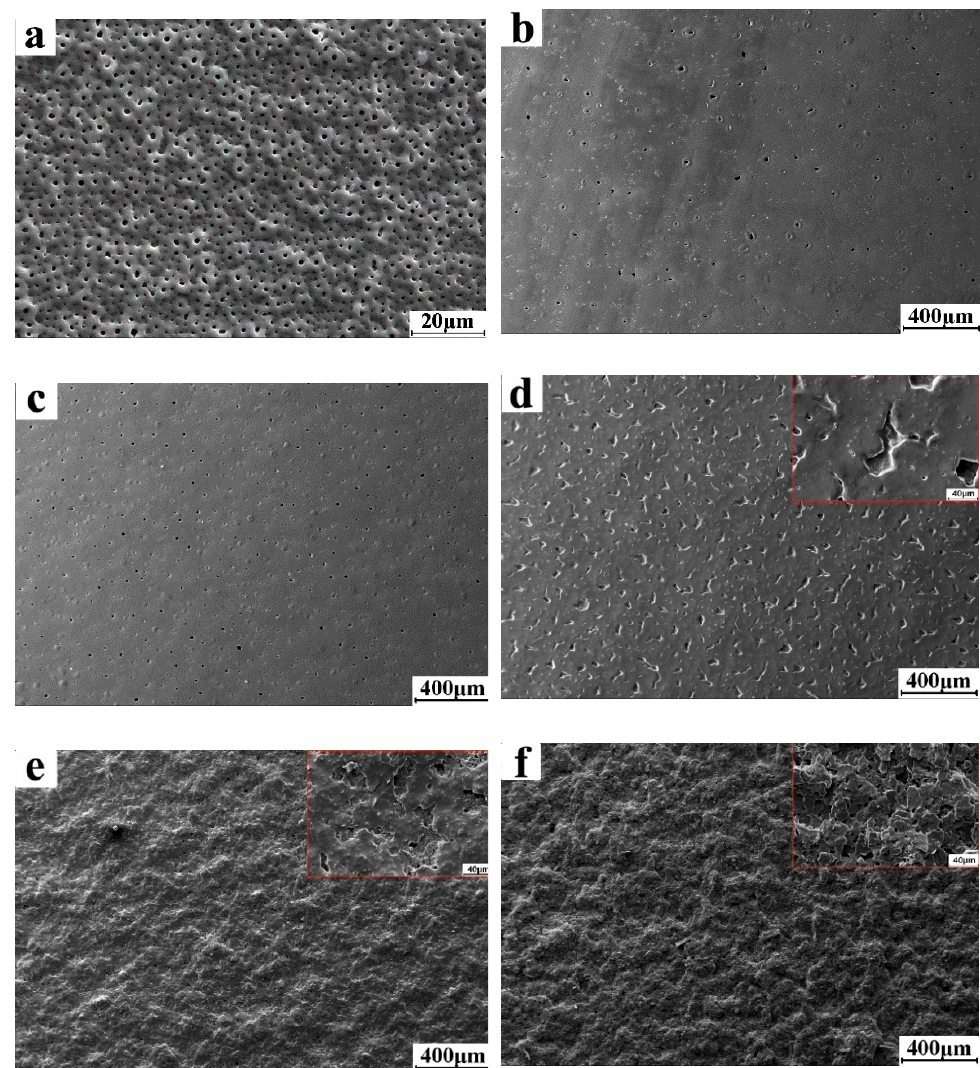
Figure 1. Surface morphologies of the ( a ) micro-arc oxidation coating and organic layers with different graphite content: ( b ) 20 wt%, ( c ) 40 wt%, ( d ) 60 wt%, ( e ) 80 wt%, and ( f ) 100 wt%.